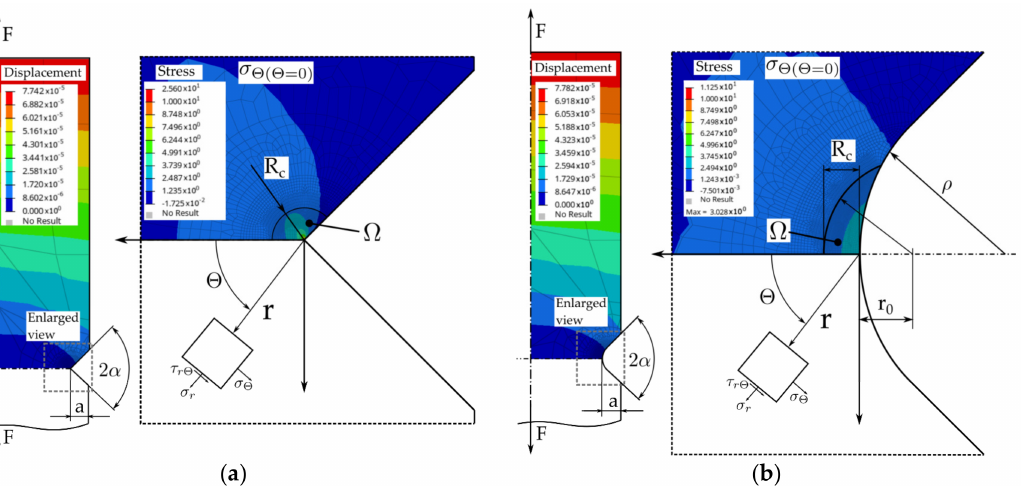
Figure 1. Dimensioned simulation results of a double V-notched plate (width W = 10 mm, opening angle 2 α = 90 ◦ , notch depth a = 1 mm, unified tension loading): ( a ) Sharp notch ( ρ = 0 mm); and ( b ) Blunt notch ( ρ = 1